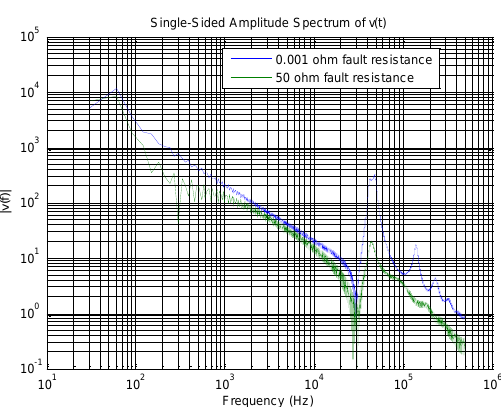
Fig. 14. FFT analysis for phase-c secondary terminal voltage waveform.